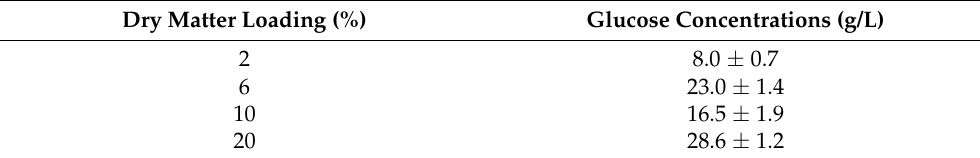
Table 4. The glucose concentrations in the hydrolysates derived from different dry matter